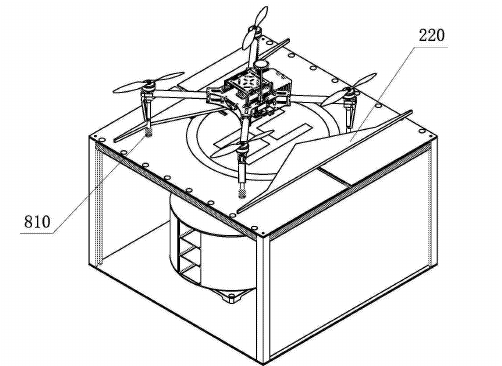
Figure 14. Landing platform with battery changer and V-shaped pushers for positioning [52]. 810, UAV leg; 220, pushers with V-shaped edges.